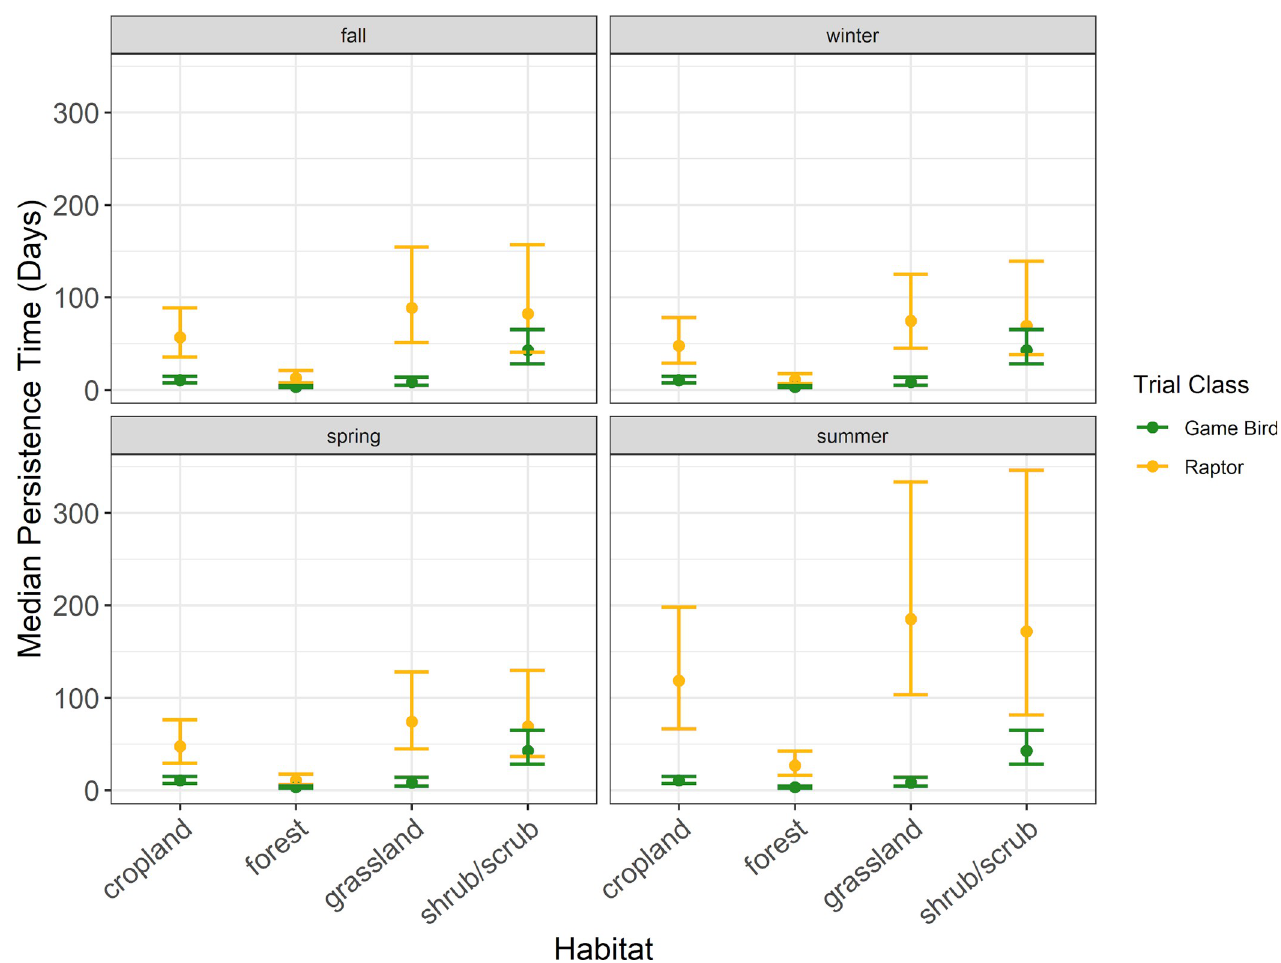
Fig 4. The median persistence times of raptor and game bird carcasses among habitat types during the carcass persistence study conducted June 2020 – August 2021.